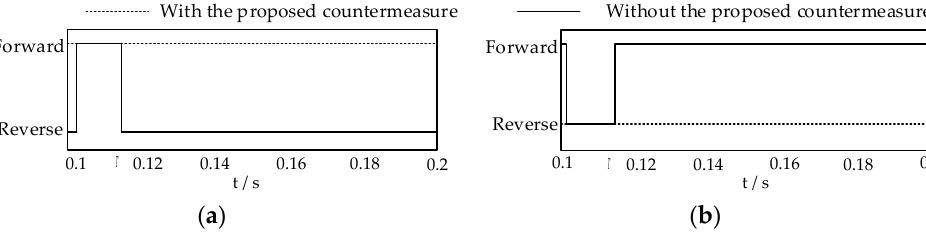
Figure 22. Operation results of the directional relay with and without the proposed countermeasure in Case 6: ( a ) busbar n ; and ( b ) busbar m .